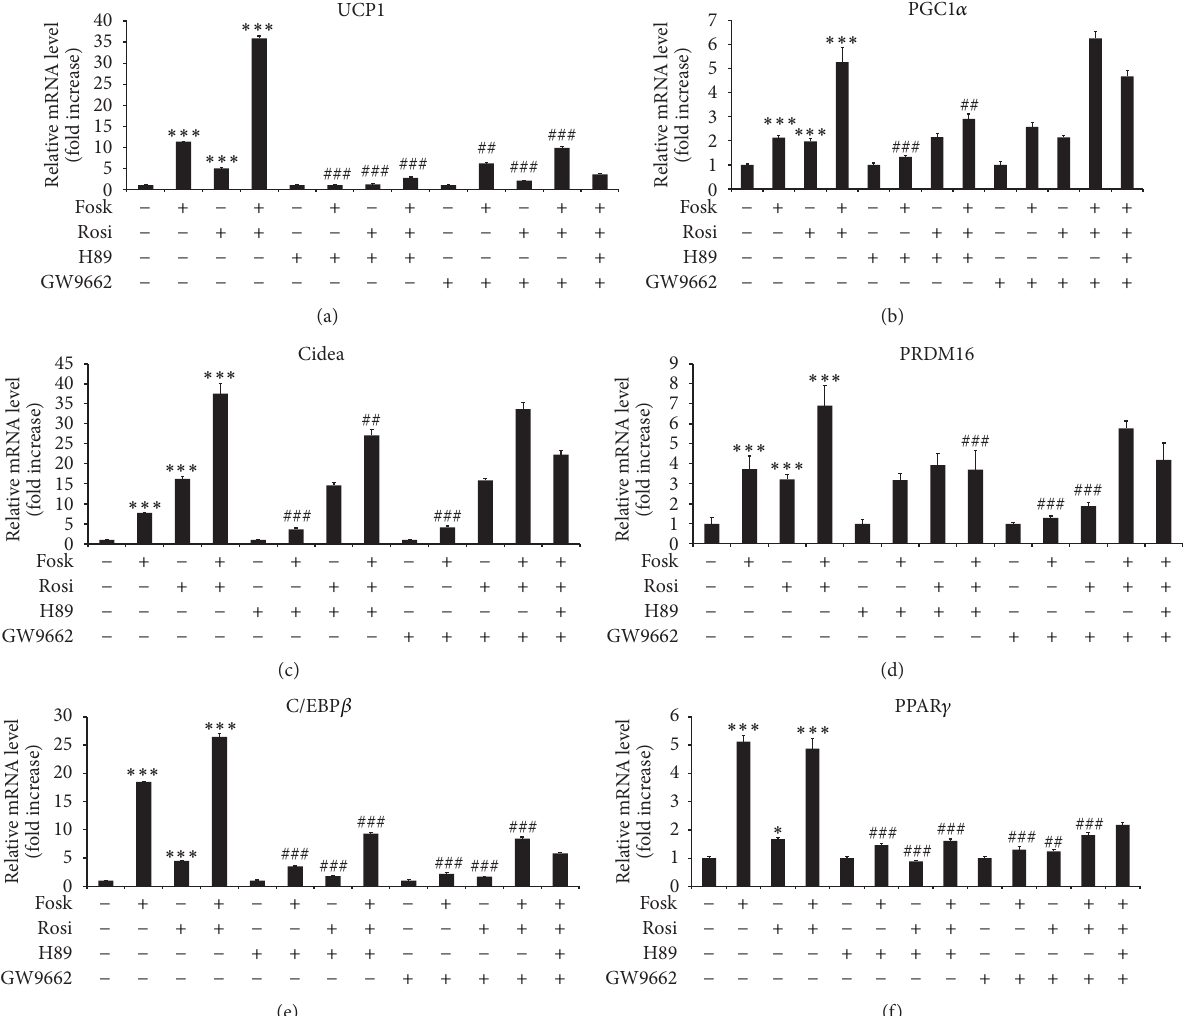
Figure 1: The effect of forskolin and rosiglitazone on mRNA expression of (a) UCP1, (b) PGC1 𝛼 , (c) Cidea, (d) PRDM16, (e) C/EBP 𝛽 , and (f) PPAR 𝛾 is mediated by PKA and PPAR 𝛾 dependent pathways. HIB-1B cells were grown to confluence and then treated with H89 (10 𝜇 M) for 1 hour or GW9662 (30 𝜇 M) for 3 hours prior to and during addition of rosiglitazone (Rosi) (10 𝜇 M) for 24 hours, or forskolin (Fosk) (10 𝜇 M) for the final 3 hours of rosiglitazone treatment, before RNA extraction, as indicated. All drugs were added in serum-free medium. Controls were treated with DMSO. Gene expression levels were analysed by quantitative real-time PCR and normalized against 36B4 expression. Error bar means the mean ± SEM of triplicate observations within a single experiment performed in triplicate. ∗∗∗ Significant difference 𝑃 < 0.001 with respect to control; ### significant difference 𝑃 < 0.001 due to H89 or GW9662 for each experiment.